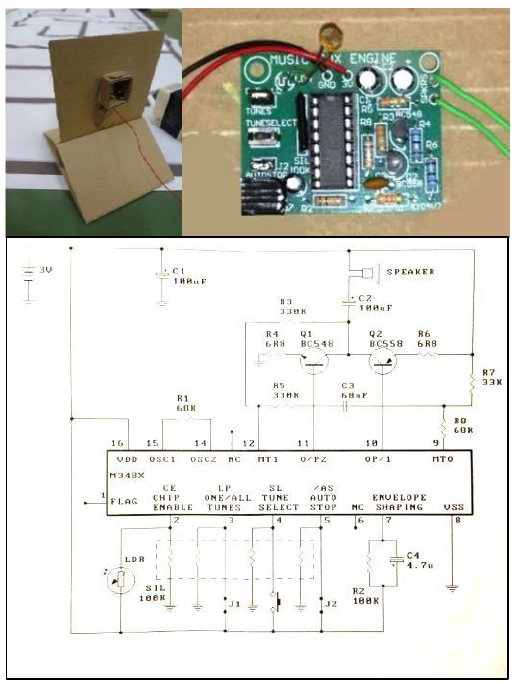
Figure 9 Light sensor (front side and backside), assembled kit and its